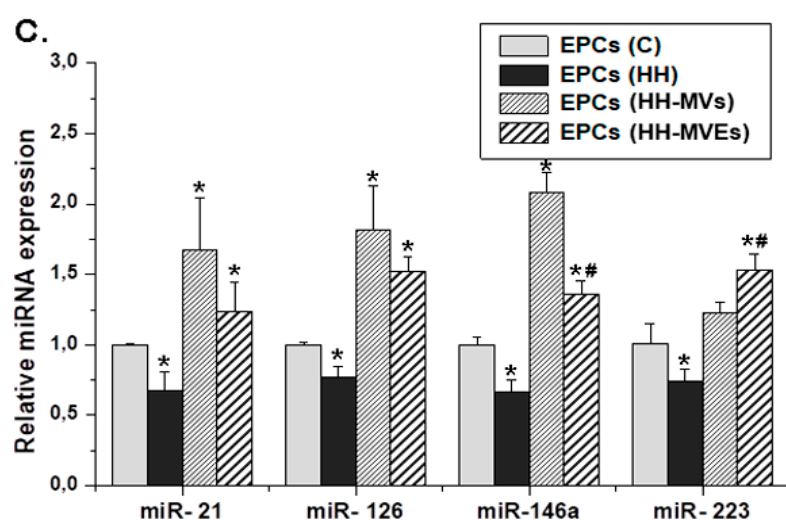
Figure 9. Evaluation of miRNA expressions in MVs ( A ) or MVEs ( B ) from the C and HH groups, and late EPCs from the C, H, HH-MVs, and HH-MVEs animal groups ( C ) by qRT-PCR ( n = 6 individual animals per group); the relative quantification of miR-21, miR-126, miR-146a, and miR-223. The statistically significant di ff erences between the groups were calculated and are represented as * p ≤ 0.05 for values vs. the C group and as # p ≤ 0.05 for values vs. the HH group (one way ANOVA analysis).